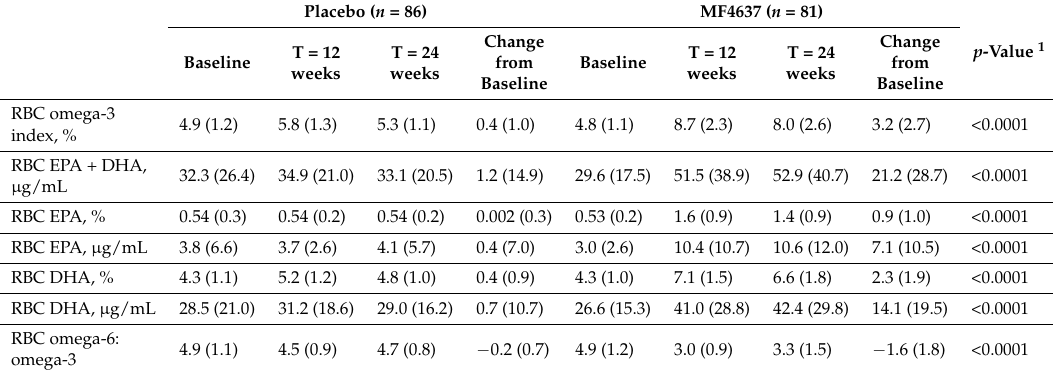
Table 3. RBC fatty acid content at baseline and after 12- and 24-week intervention with placebo or